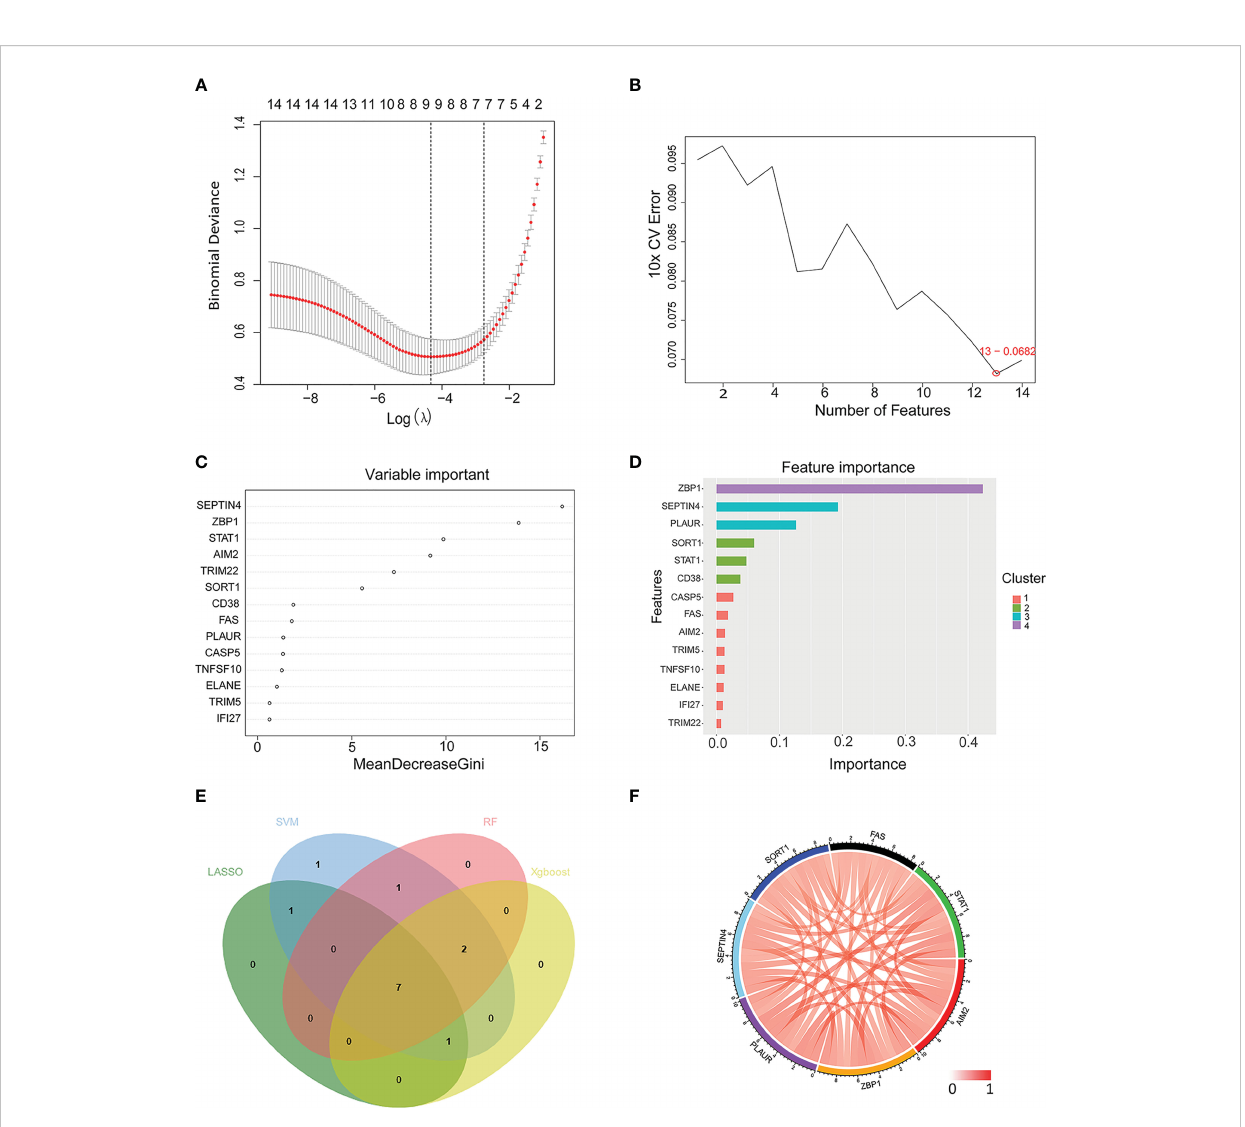
FIGURE 5 Machine learning-based selection of a PCD-related gene signature. (A – D) Use of LASSO regression, SVM, RF, and Xgboost approaches to construct a PCD-related gene signature associated with TB. (E) A Venn diagram highlighting overlap among candidate genes identi fi ed with these four machine learning algorithms. (F) A Circos plot displaying the relationship between the overlapping PCD-related genes. LASSO, least absolute shrinkage and selection operator; SVM, support vector machine; RF, random forest; Xgboost, eXtreme Gradient